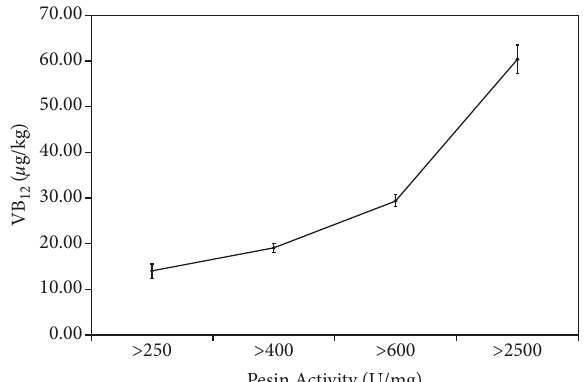
Figure 3: Relationship of background value of vitamin B pepsin